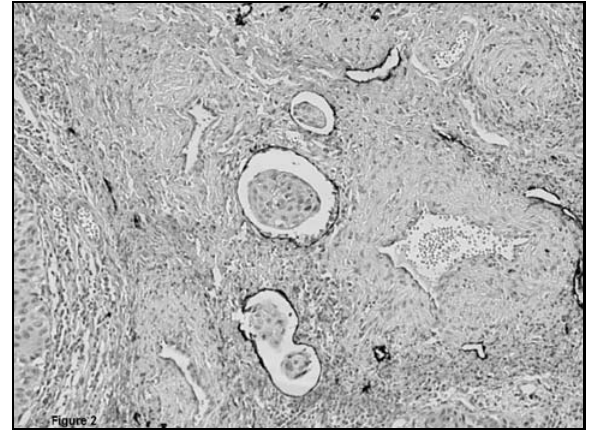
Figure 3 – Basic mechanisms of lymphangiogenesis in cancer setting based on VEGF family activities. Note that the molecular cross-talk with angiogenic differentiation is also